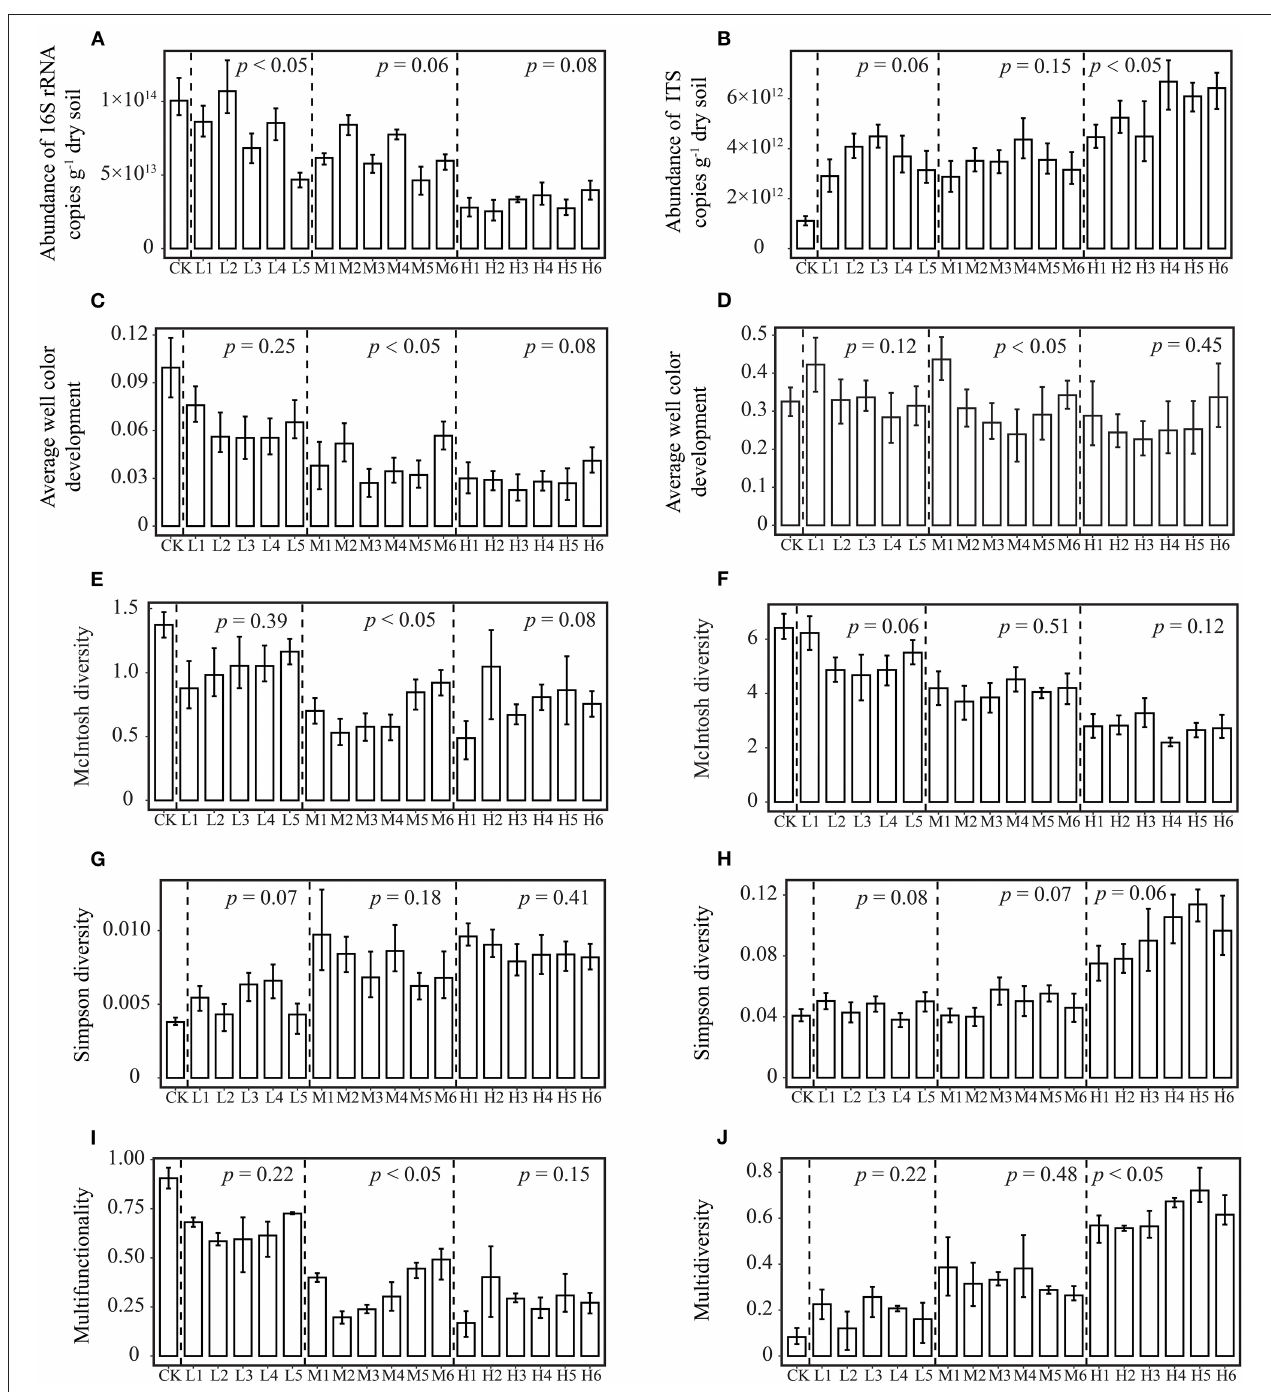
FIGURE 1 | Differences in microbial parameters among different treatments at the same RI level. 16S rRNA (A) and ITS genes abundance (B) ; Average well color development in Biolog Ecoplate (C) and FFplate (D) ; McIntosh diversity of bacteria (E) and fungi (F) ; Simpson diversity of bacteria (G) and fungi (H) ; multifunctionality (I) and multidiversity (J) index of microorganisms. Uncontaminated original soil as control (CK). Low level (L, RI = 100) includes L1-L5 treatments. Moderate level (M, RI = 200) includes M1-M6 treatments. High level (H, RI = 400) includes H1-H6 treatments. ANOVA was used to determine whether the differences in various indexes are significant ( p < 0.05) among different treatments at the same RI